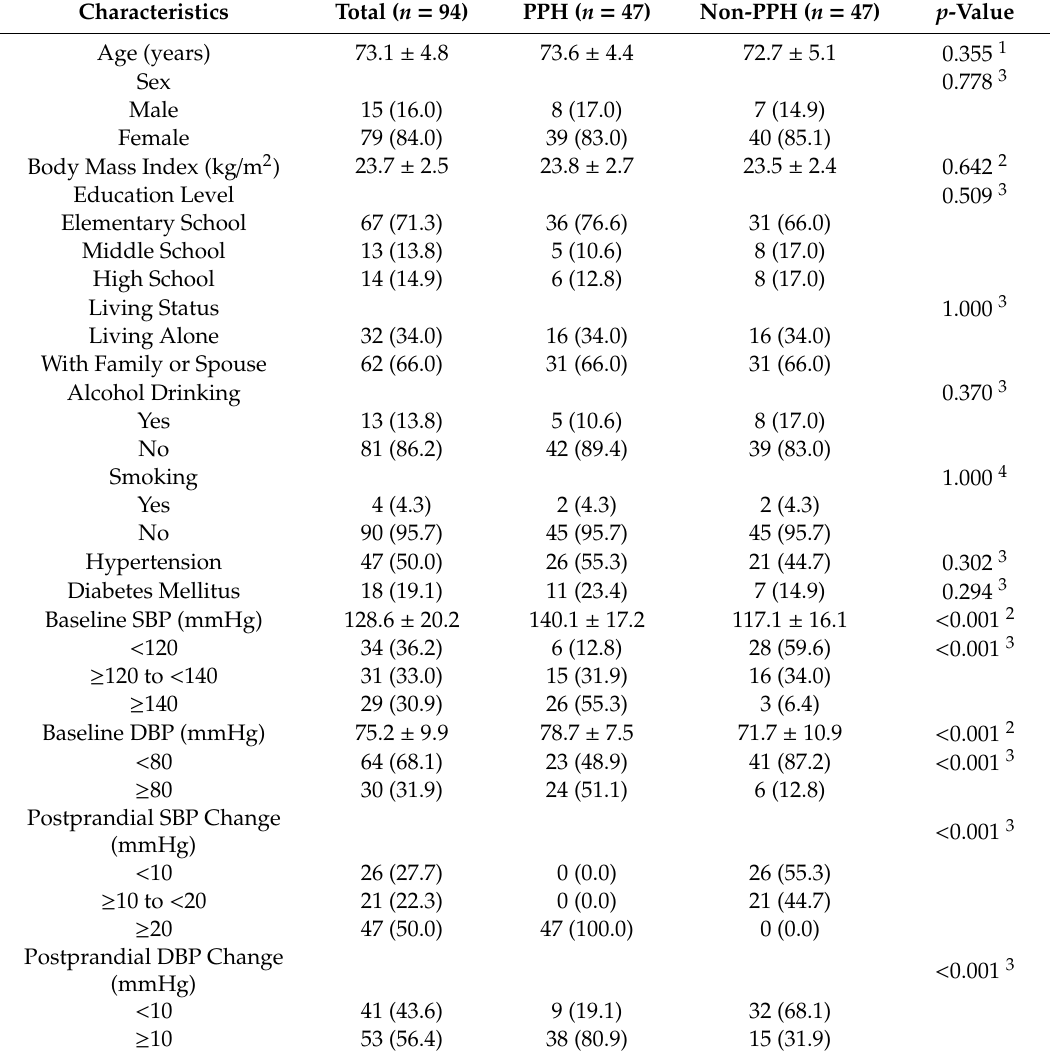
Table 1. Baseline characteristics of participants with and without